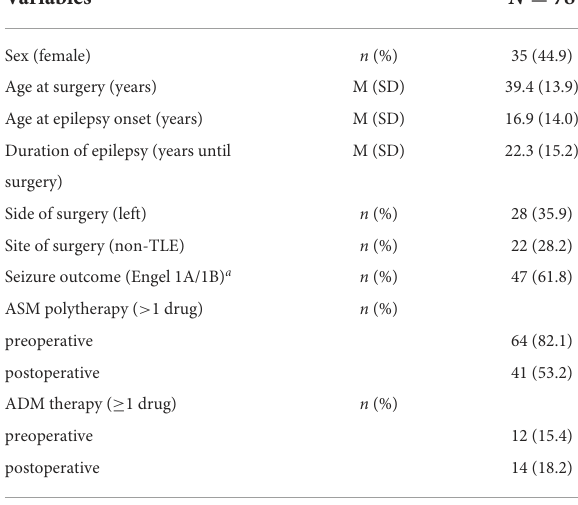
TABLE 1 Medical and demographic characteristics of the patient